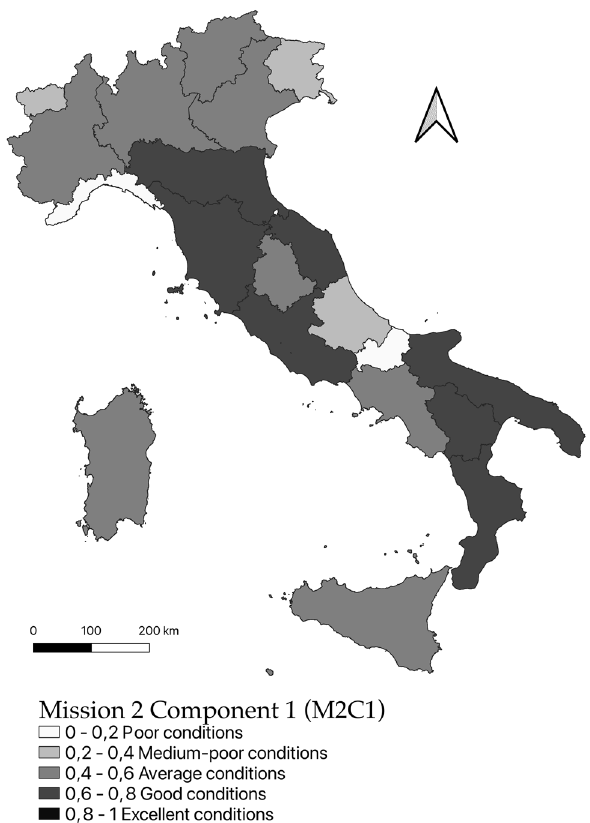
Figure 2. Territorial distribution by region of the fuzzy values for Mission 2 Component 1 (Circular Economy and Sustainable